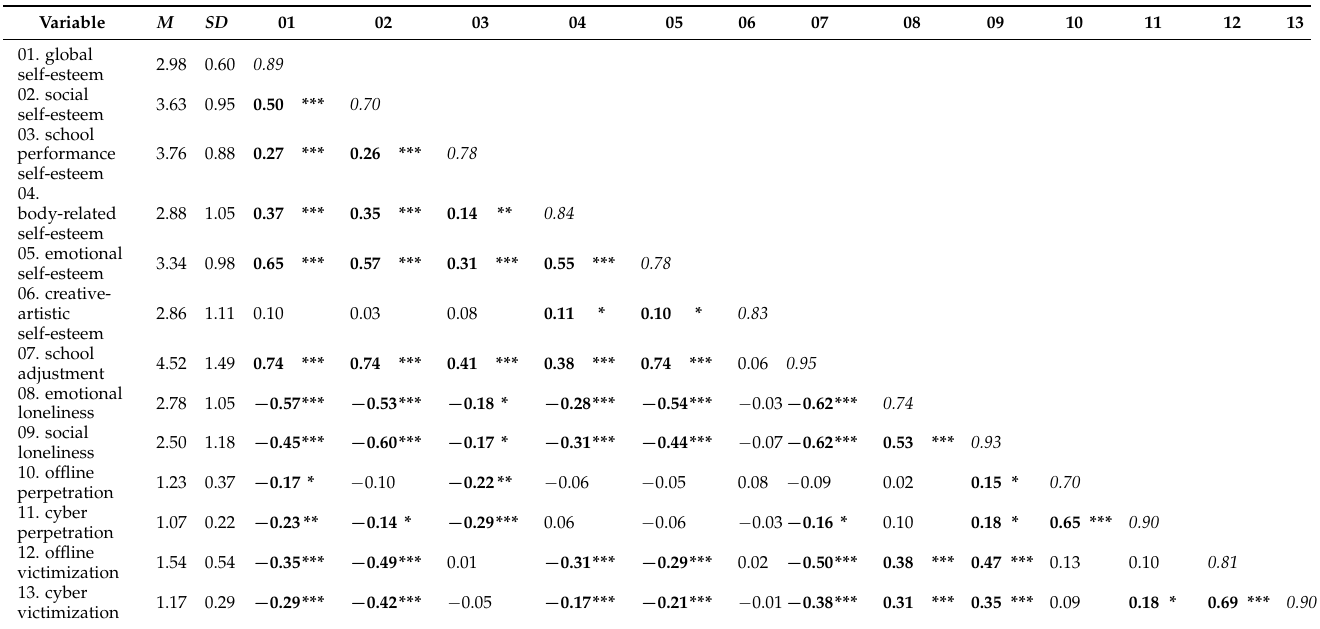
Table 1. Descriptive Statistics and Bivariate Correlations of the Study